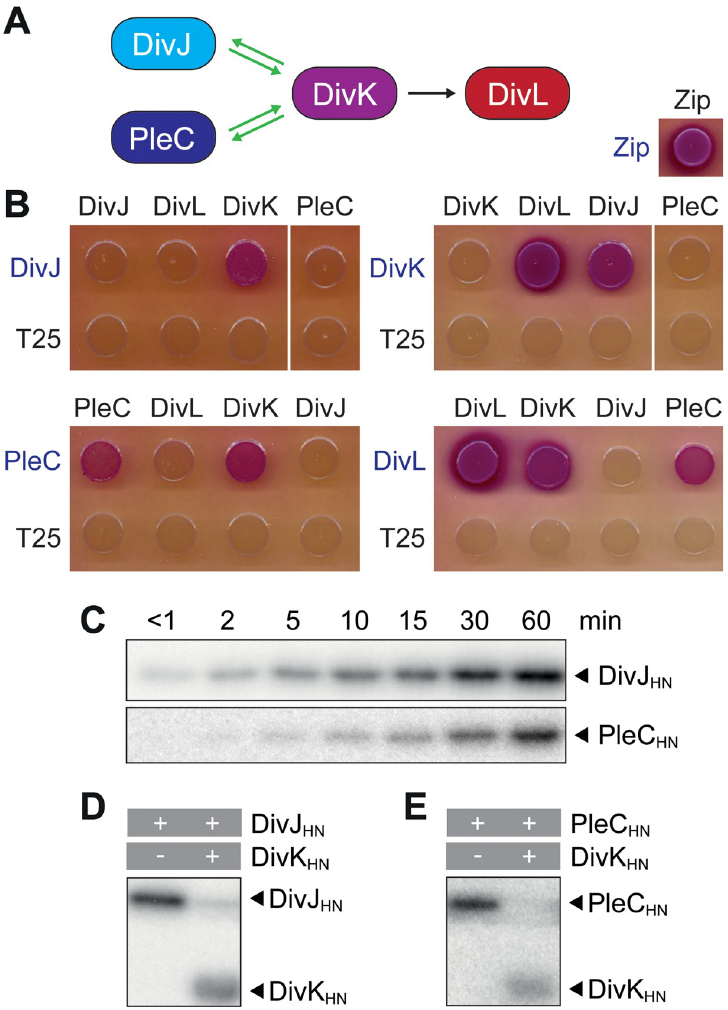
Fig 6. The connectivity within the DivJ/PleC-DivK module is conserved in H . neptunium . (A) Scheme of the interactions within the DivJ/PleC-DivK-DivL module, as demonstrated in this study. Green arrows indicate phosphotransfer. The black arrow indicates a regulatory protein-protein interaction. (B) Bacterial two-hybrid assay testing for interactions between the proteins in the DivJ/PleC-DivK-DivL. The indicated proteins were fused to the T18 (black) or T25 (blue) subunit of adenylate cyclase from Bordetella pertussis , respectively. The fusions were produced in the reporter strain E . coli BTH101, and their interaction was analyzed by spotting of the cells on MacConkey agar. Interactions are indicated by a purple coloration of the colonies. The GCN4 leucin-zipper-region from yeast (Zip) was used as positive control, and empty vectors encoding only the T25 subunit as negative controls. (C) Autophosphorylation of DivJ HN and PleC HN upon incubation with [ γ 32 P]-ATP. Samples were taken at the indicated time points and analyzed by SDS-PAGE. Radioactivity was detected by phosphor imaging. (D) and (E) In vitro phosphotransfer from (D) DivJ HN and (E) PleC HN to DivK HN . After autophosphorylation of DivJ HN for 30 min and of PleC HN for 45 min, the indicated proteins (marked with pluses) were incubated for 90 sec. After addition of SDS sample buffer to stop the reactions, the mixtures were separated by SDS-PAGE, and radioactivity was detected by phosphor